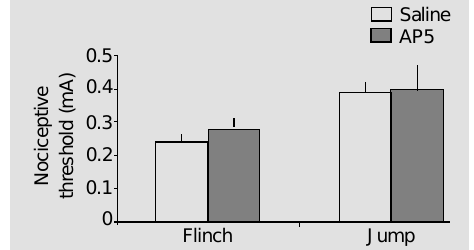
JumpFigure 3 - Effect of intra-amyg- dala infusion of D , L -2-amino-5- phosphonopentanoic acid (AP5) on reactivity to the footshock. Data are flinch and jump thresh-